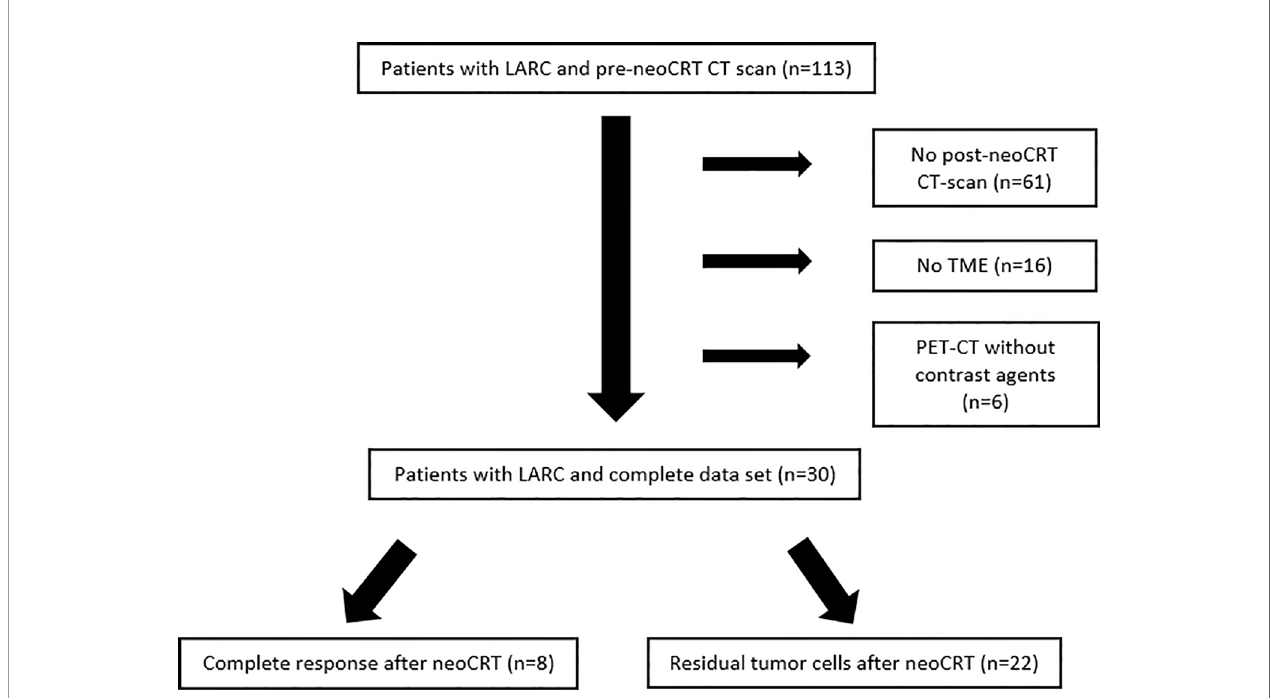
FIGURE 2 | Patients with LARC and pre-neoCRT CT-scan screened for the study between 06/2012 and 04/2020. Most patients were excluded because of missing post-neoCRT